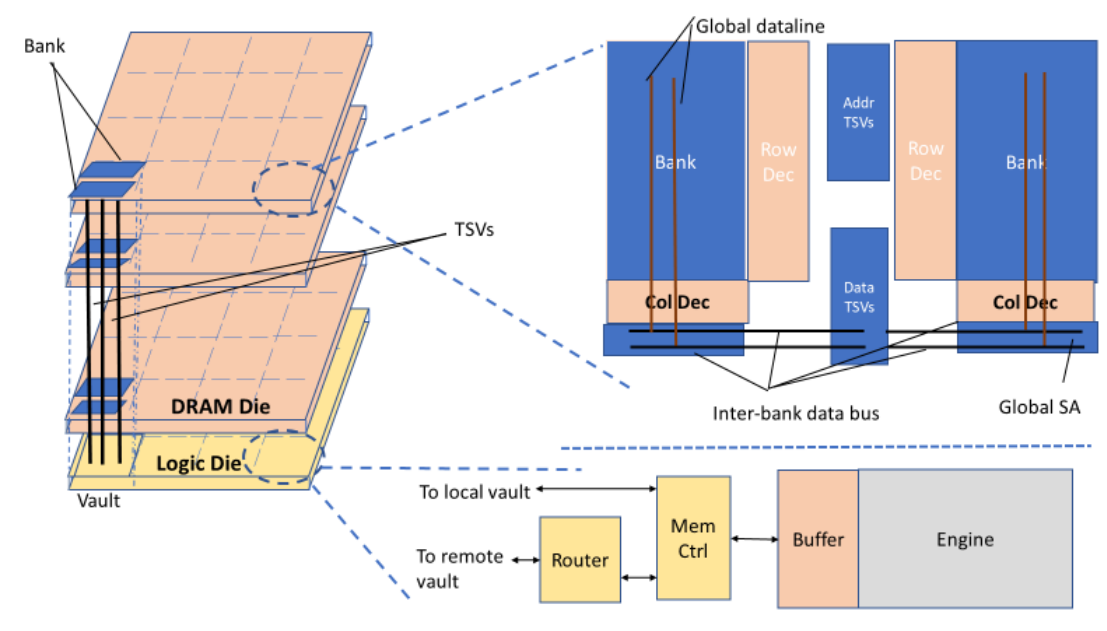
Figure 6. Architecture of TETRIS [5].